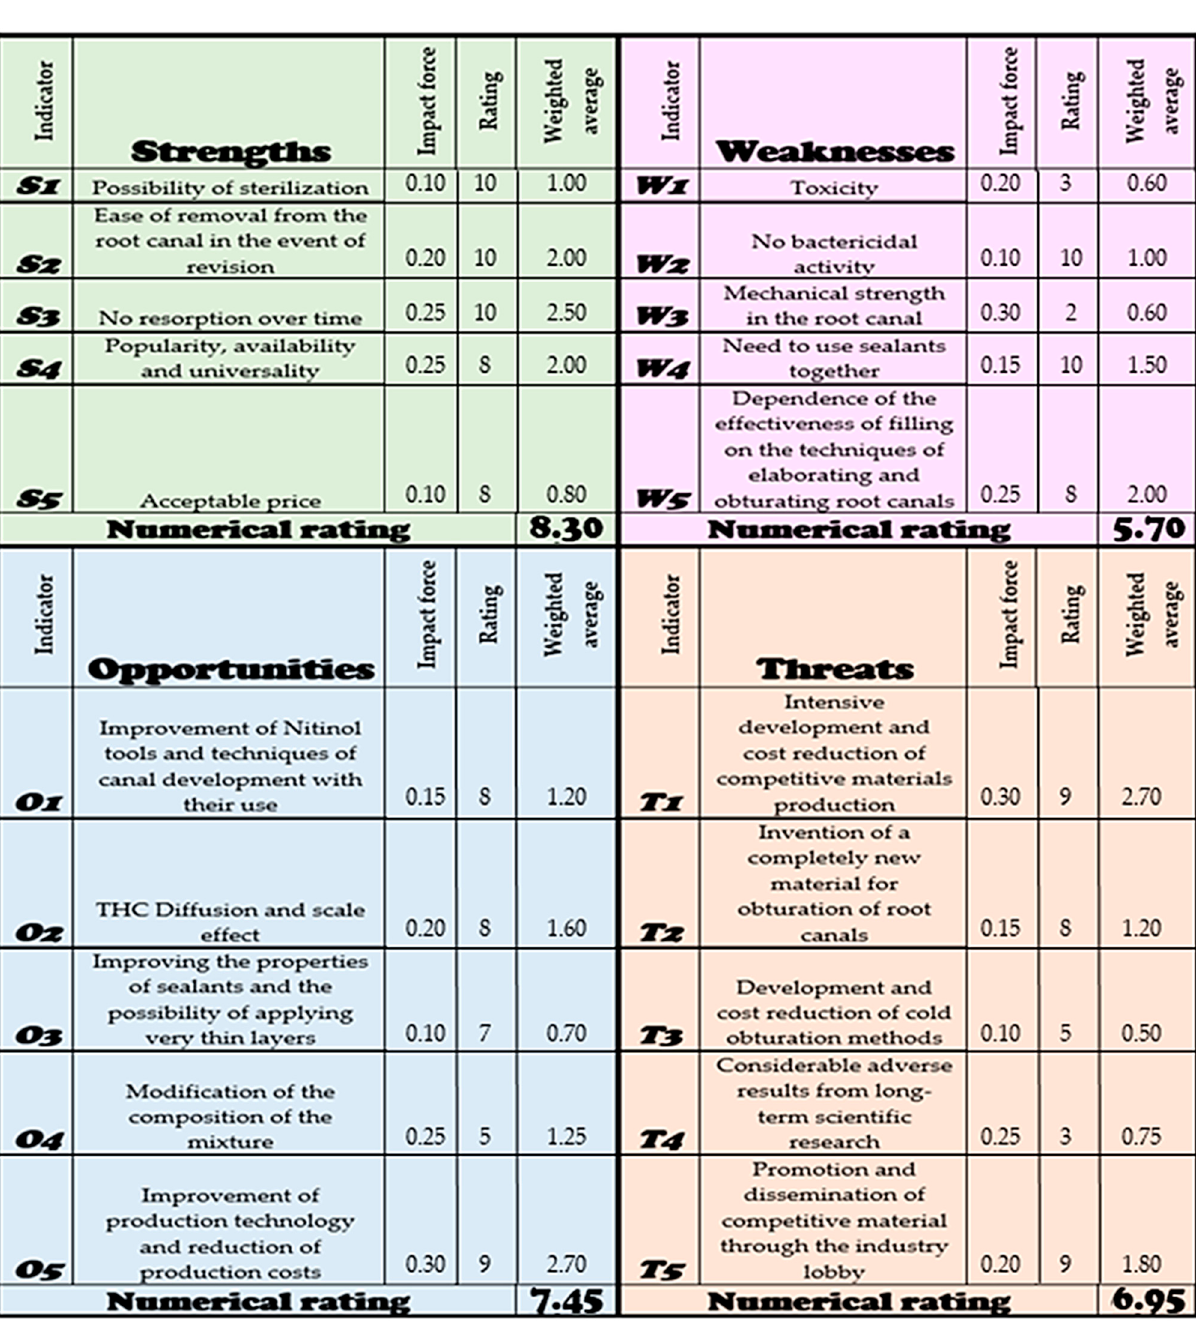
Figure 20. SWOT point analysis matrix (strengths, weaknesses, opportunities, threats) containing criteria and results for gutta-percha-based filling material used for root canal filling in endodontics.